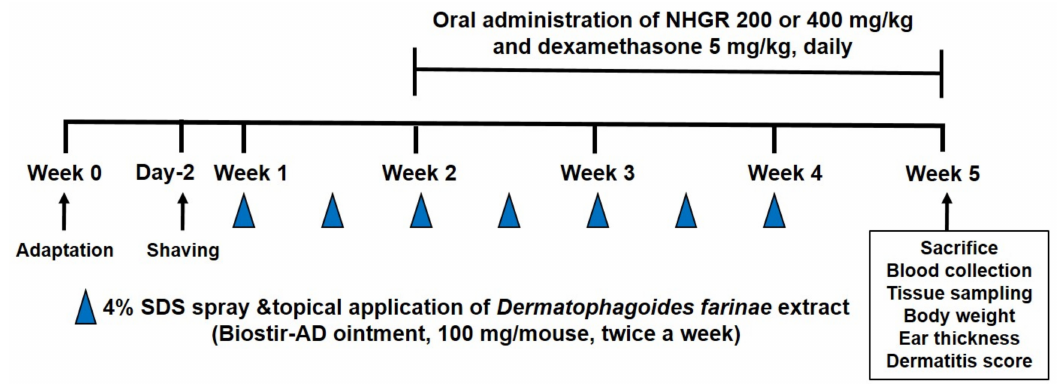
Figure 1. Experimental design for induction of atopic dermatitis and application with the Siraitia grosvenorii residual extract (NHGR) in